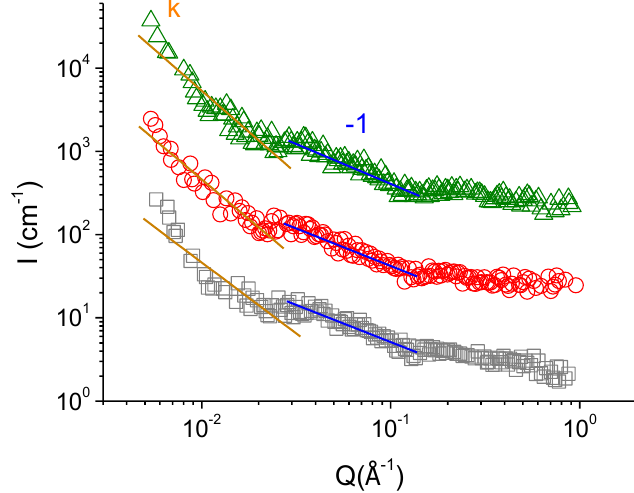
Figure 5. SANS curves of saturated P4VP/potassium oleate complexes in the presence of different concentrations of KCl: 67 mM (squares), 110 mM (circles) and 160 mM (triangles). Solvent: 10 vol% of D 2 O/90 vol% H 2 O at pH 11. Blue solid lines show slopes of the Q −1 dependences. Orange solid lines show the slope of the curves in the low- Q range. Table 2. Power-law k of the SANS curves in the low- Q region for saturated P4VP/potassium oleate complexes in the presence of different concentrations of KCl obtained upon contrast matching of the scattering from potassium oleate (solvent: 10 vol% D 2 O/90 vol% H 2 O at pH 11). Concentration of KCl, mM